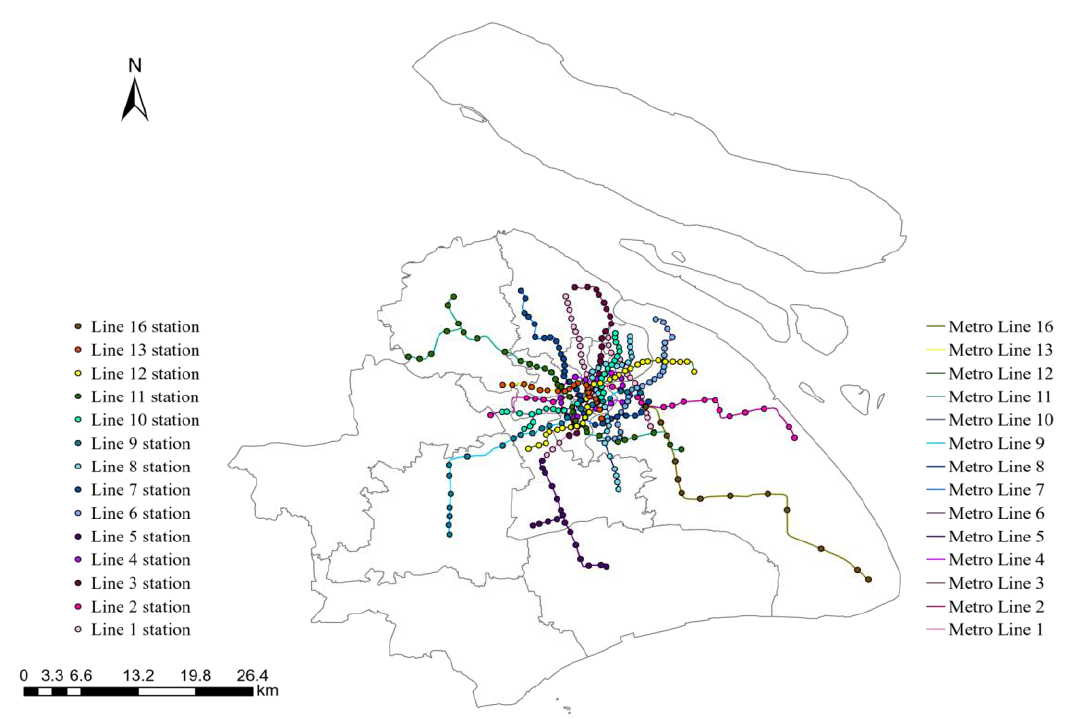
Figure 1. Rail transit network in Shanghai.